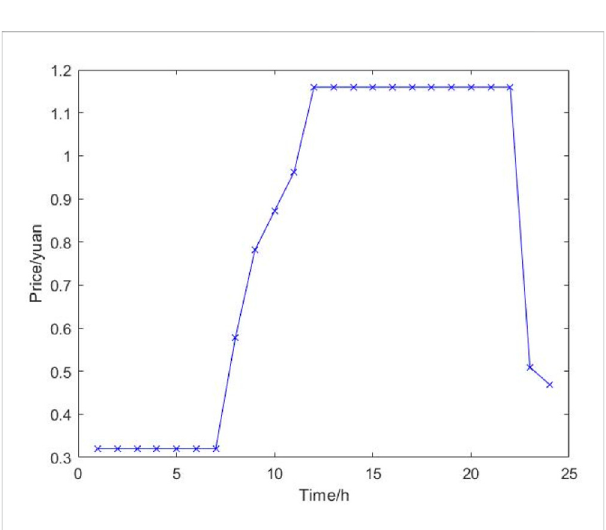
FIGURE 4 Time-of-use electricity